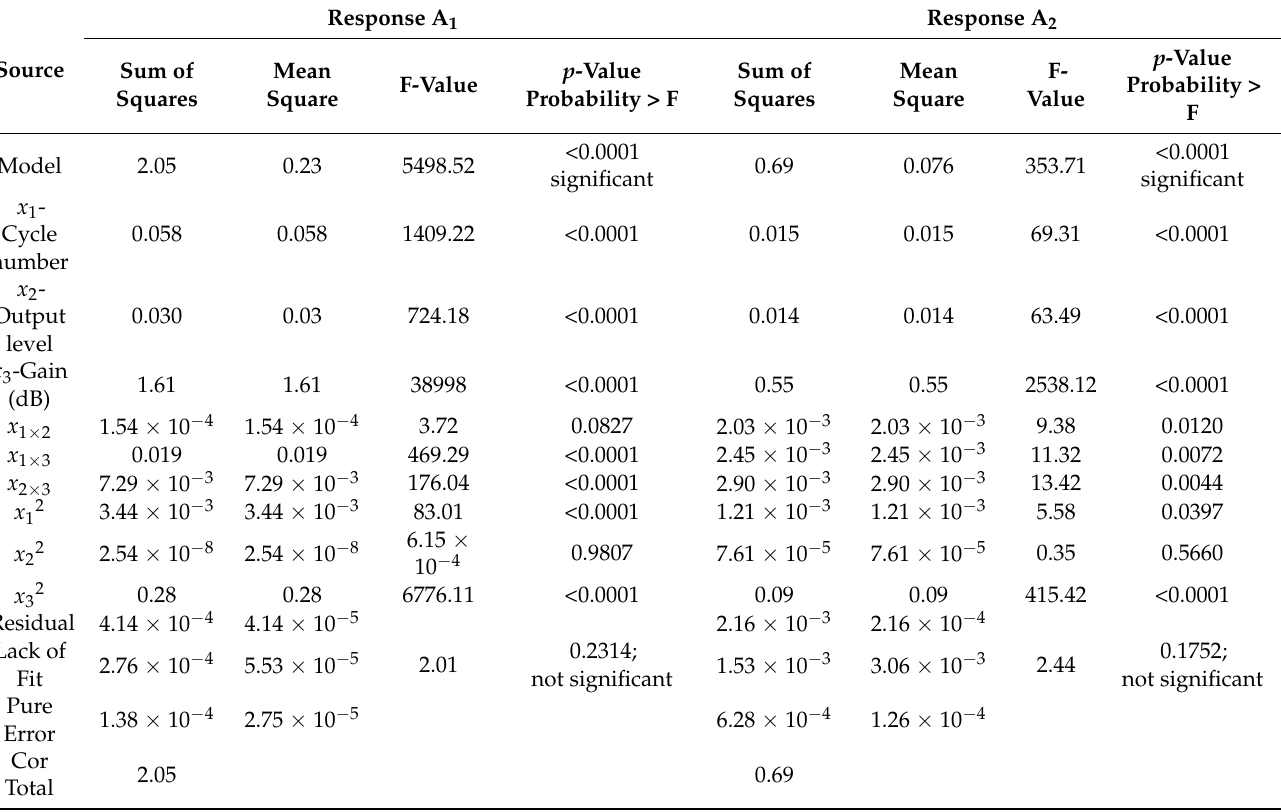
Table 3. ANOVA results of the fitted quadratic regression models.